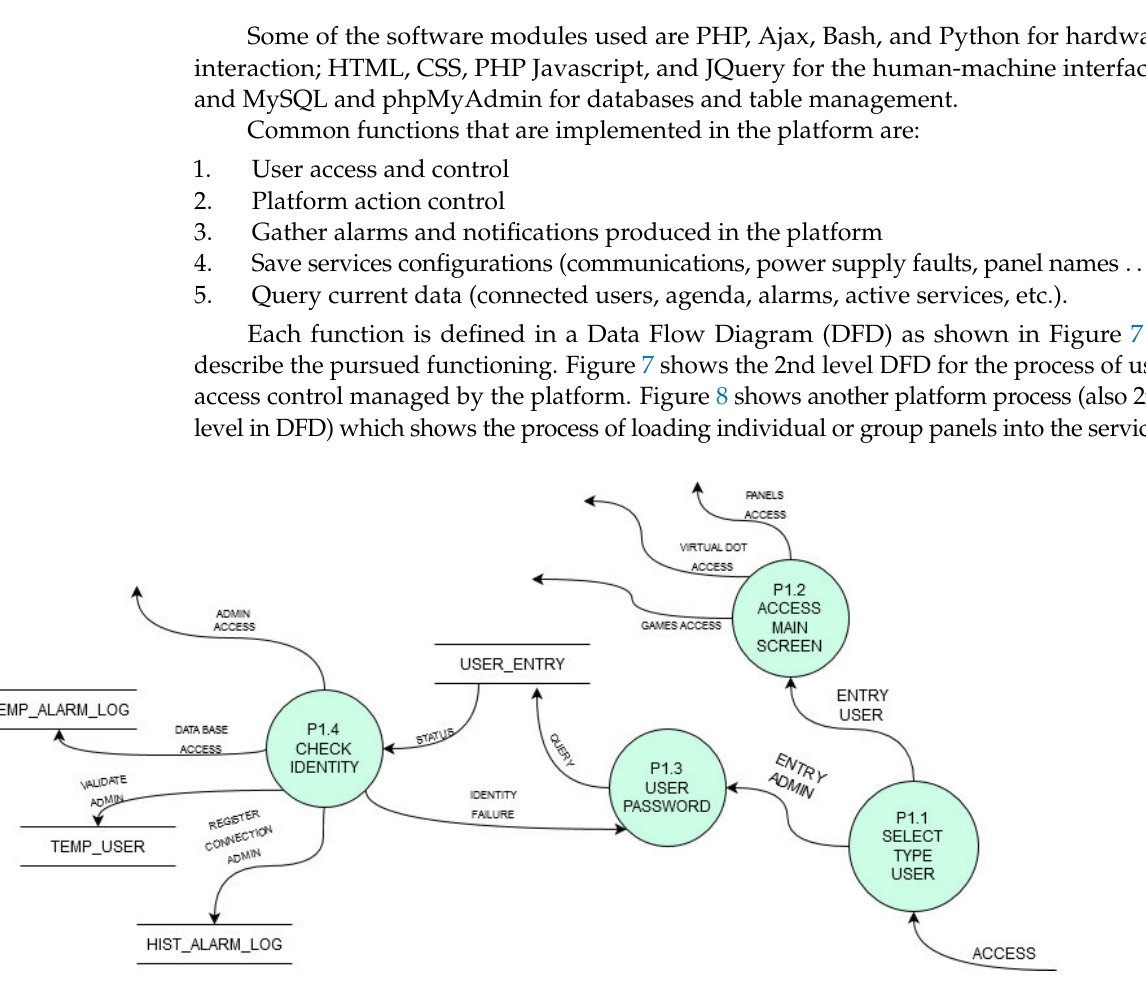
Figure 7. Platform user access control defined in DFD.